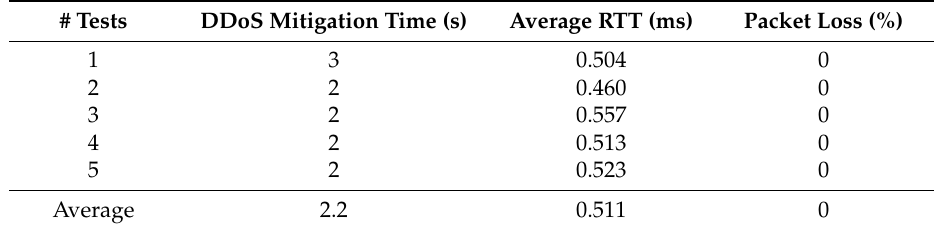
Table 5. Scenario II—Performance Results.